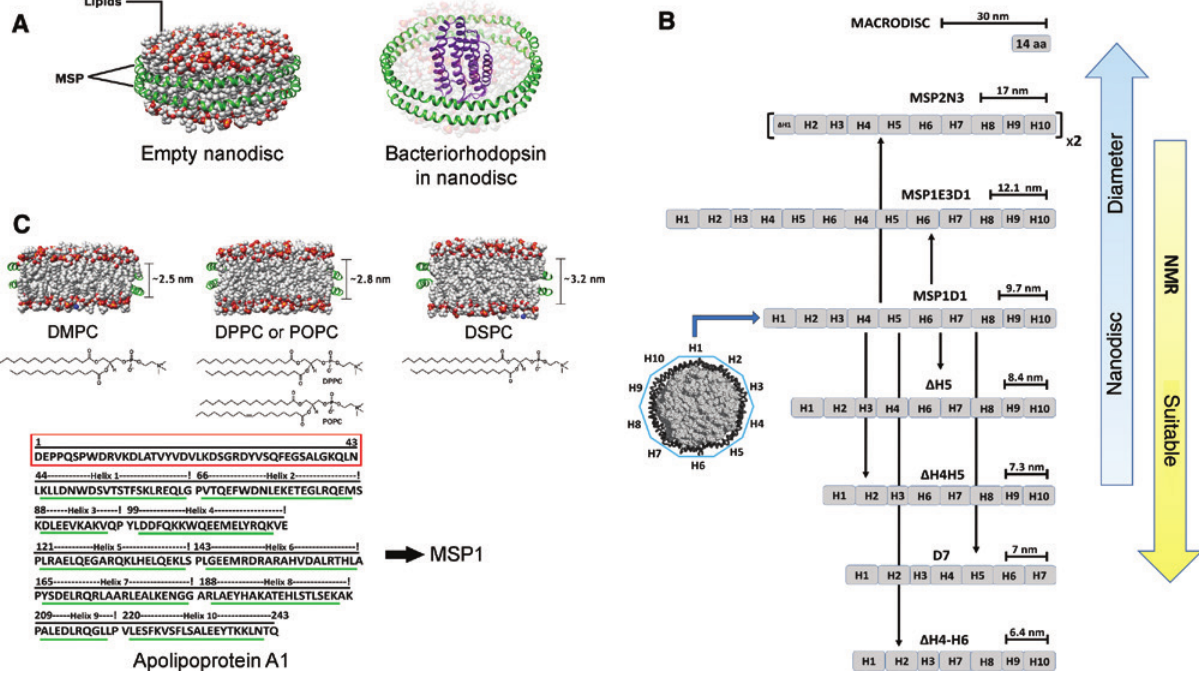
Figure 1: Nanodisc models were constructed using the nanodisc builder from CHARMM GUI [10]. (A) Visual representation of a nanodisc that is either empty or contains bacteriorhodopsin (PDB: 1R2N). The outer belt protein MSP is shown in green while the lipid molecules are colored by atom type, where carbon is gray, oxygen is red, phosphorus is orange, and nitrogen is blue. The lipids are rendered partially transparent in order to distinguish bacteriorhodopsin from nanodisc. (B) Schematic representation of the overall length and nanodisc diameters for several MSP1D1 variants. The arrow indicates the scheme for the addition or deletion of helices from the core MSP1D1 leading to MSP with varying lengths. Nanodiscs with smaller diameters are preferred for NMR studies. The largest “MACRODISC” was obtained from a singular 14 amino acid peptide producing a disc with a diameter of 30 nm while the smallest disc, with a diameter of 6.4 nm, was obtained by deleting helices 4–6 from the MSP1D1 construct. (C) Depiction of the approximate hydrocarbon thickness of nanodisc bilayers composed of commonly used phosphatidylcholines. As shown, DMPC is the smallest, DPPC and POPC have similar thickness, and DSPC is the largest [11]. The chemical structure of each lipid is presented underneath (top panel). The complete sequence of apolipoprotein A-1 is shown emphasizing each individual helix. MSP1 construct, represented by the green lines, was created by deleting the N-terminal region highlighted in the red box (bottom